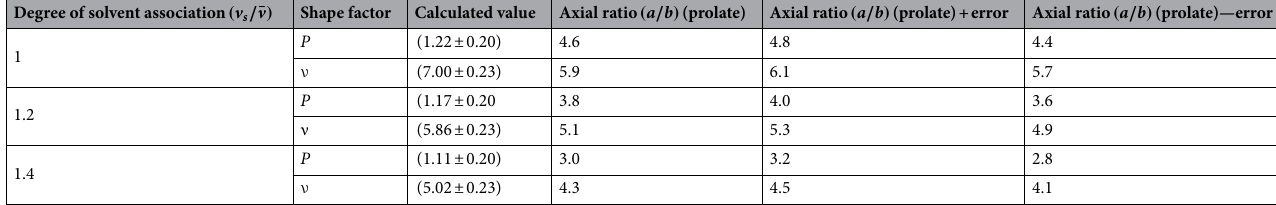
Table 2. The calculated values for the two different shape parameters P and ν at different degrees of solvent association (dynamic binding), along with the axial ratios determined by ELLIPS1. The axial ratios obtained by adding or subtracting the error from the calculated value (± 0.20 for P and ± 0.23 for ν) are also shown.